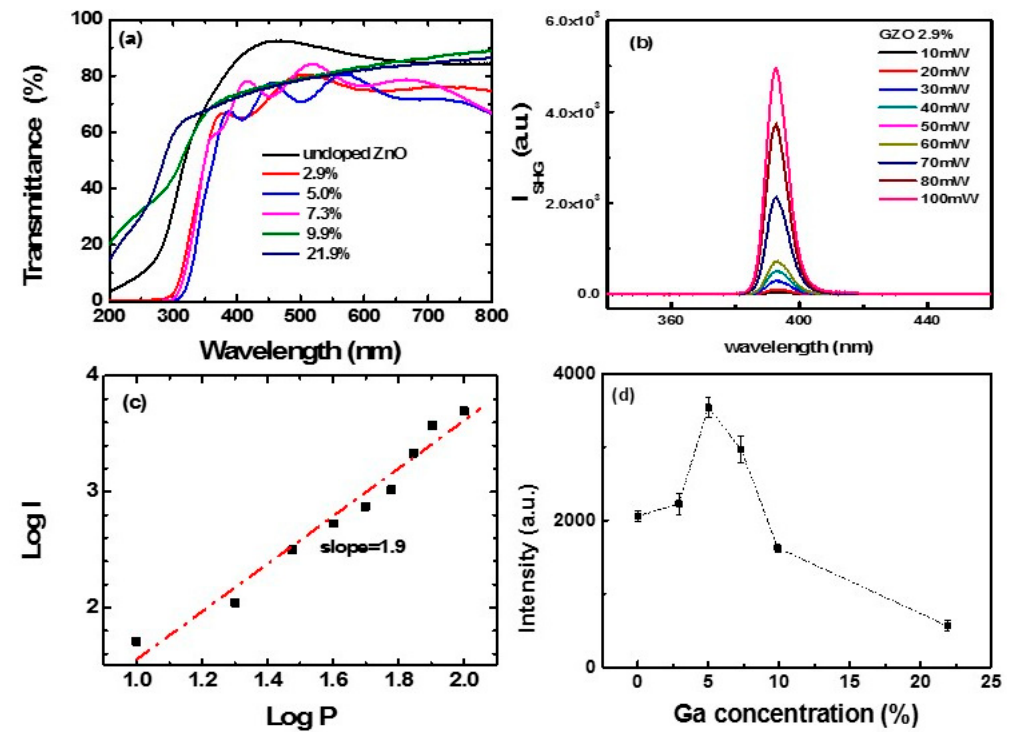
Figure 4. ( a ) Transmission spectra of the GZO films; ( b ) the spectra of SHG signal originated from 2.9% doped GZO film under different incident laser power; ( c ) the output SHG intensity as a function of the incident laser power. ( d ) SHG intensity changes as the Ga doping concentration increased. Dotted line is guide to the eye.